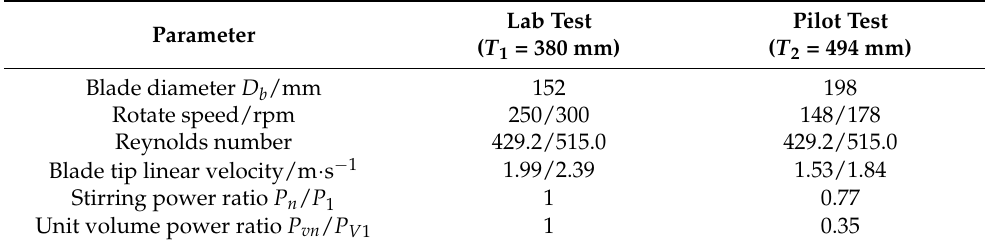
Table 5. Working condition parameters based on the same Reynolds